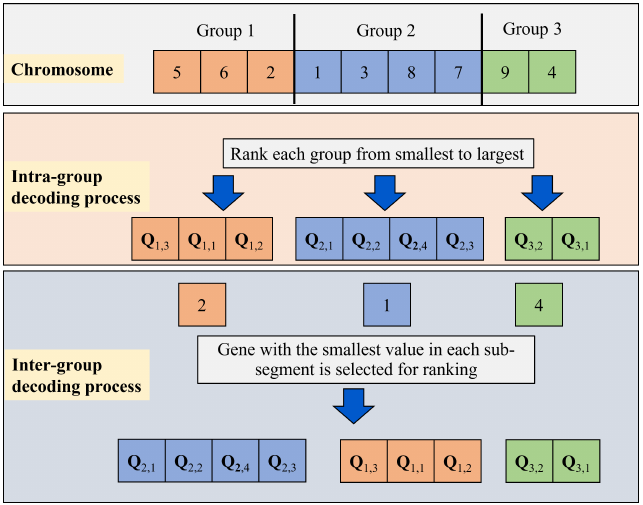
Figure 7. Schematic of the decoding